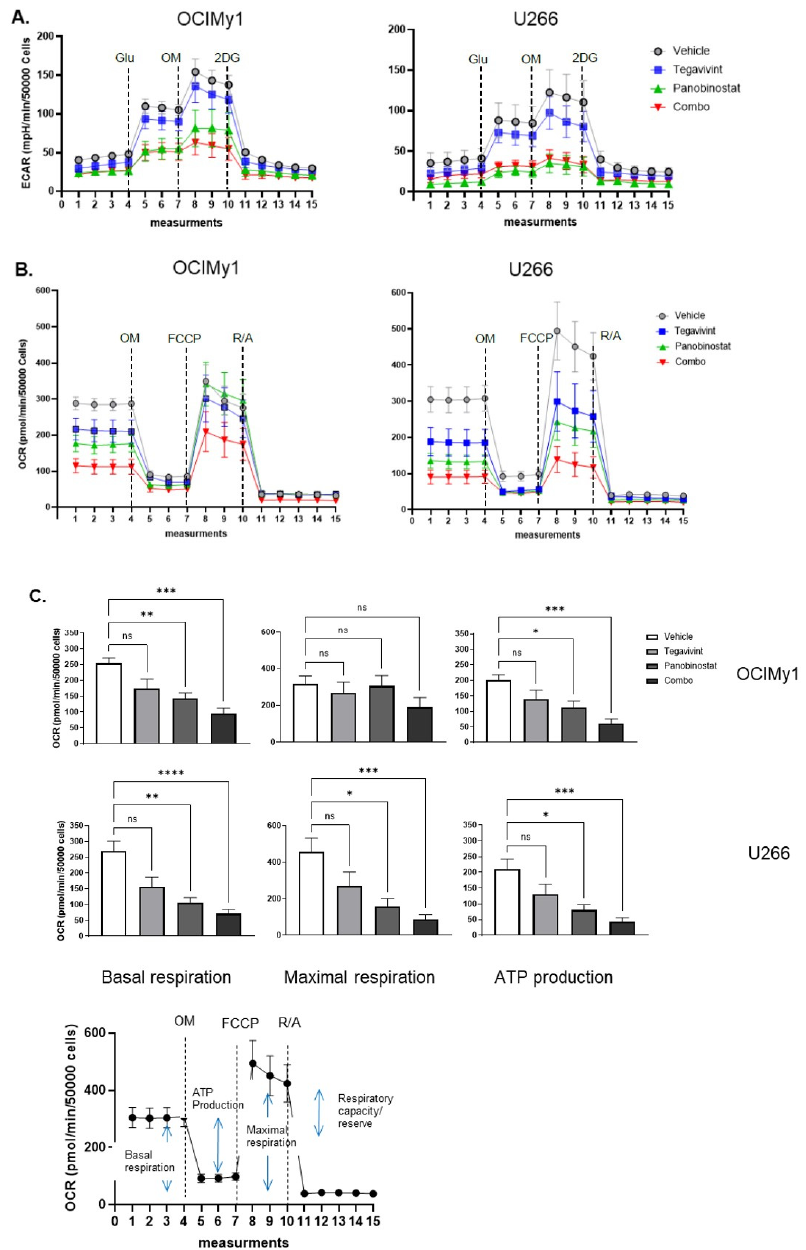
Figure 4. Tegavivint in combination with panobinostat reduces oxidative phosphorylation of MM cells. ( A ) OCIMy1 and U266 cells were treated with vehicle, 100 nmol/L of Tegavivint, 10 nmol/L of panobinostat, or the combination for 18 h. Analysis of ECAR (extracellular acidification rate) was performed using a Seahorse XF analyser to assess glycolysis in the context of a glycolysis stress test. Three technical replicates were performed for each experimental variable ( n = 3, ± SE) (Glu: glucose, OM: oligomycin, 2DG: 2-deoxy-D-glucose). ( B ) OCIMy1 and U266 cells were treated similarly to Figure 3A for 18 h. Analysis of OCR (oxygen consumption rate) was performed using a Seahorse XF analyser to assess mitochondrial respiration/oxphos (oxidative phosphorylation) in the context of a mitochondrial stress test. Three technical replicates were performed for each experimental variable ( n = 3, ± SE) (OM: oligomycin, FCCP: carbonyl cyanide 4-(trifluoromethoxy)phenylhydrazone R/A: rotenone/antimycin). ( C ) Results from the OCR analysis were further analysed and the basal respiration, maximal respiration, and ATP production for OCIMy1 and U266 were calculated ( n = 3, ± SE) (nonparametric Kruskal–Wallis multiple comparisons test * p ≤ 0.05, ** p ≤ 0.01, *** p ≤ 0.001, **** p ≤